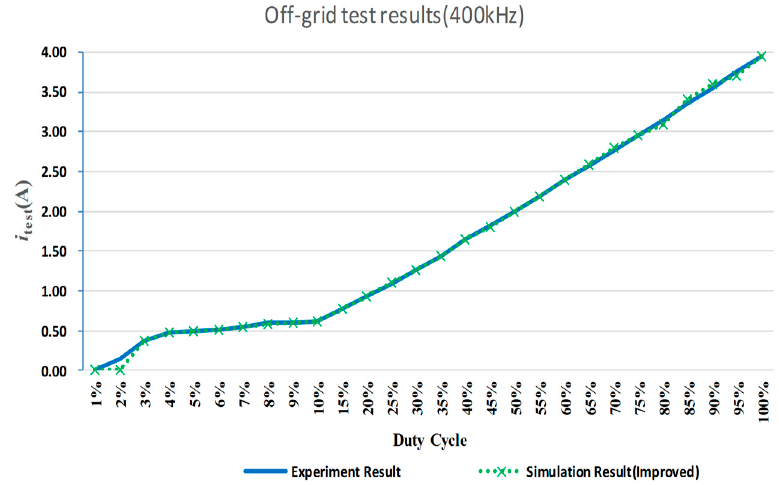
Figure 14. The current respond between improved simulation and experiment.